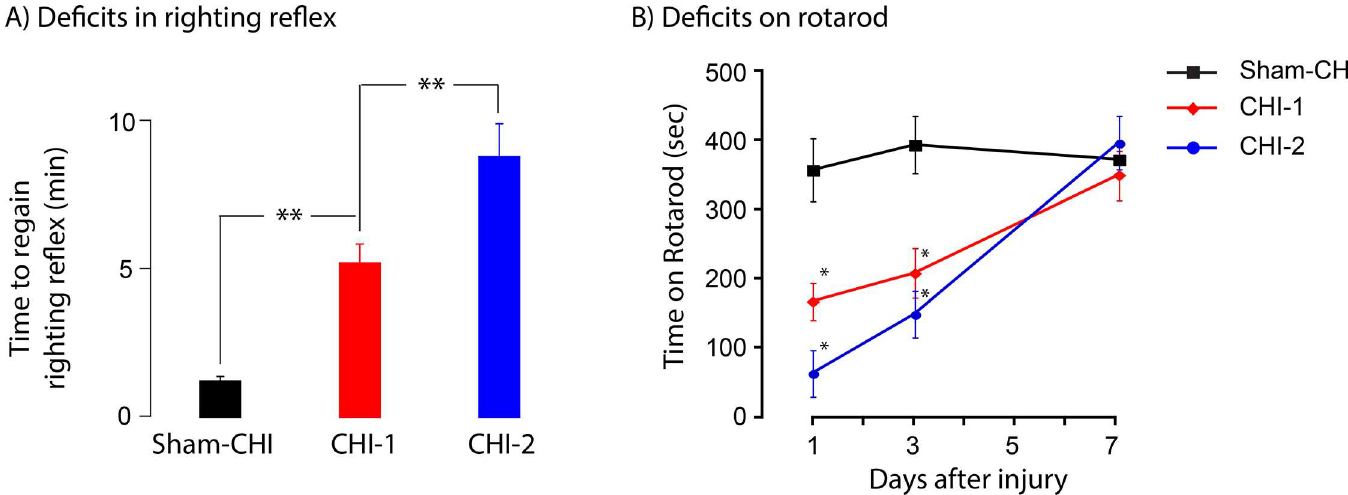
Fig 1. CHI-1 and CHI-2 mice have differing deficits in righting reflex and rotarod after closed head injury. Panel A, Assessment of righting reflex. Recovery of righting reflex differed among sham-CHI, CHI-1 and CHI-2 mice (ANOVA, F 2,30 = 18.4, p < 0.001). Sham-CHI mice recovered righting reflex most rapidly followedby CHI-1 and then by CHI-2 (post hoc p < 0.01). Panel B, One, three and seven days after either sham-CHI or CHI, mice received four 5-minute trials on the rotarod. Performance on the rotarod had a significant interaction between group and time (F 4,14 = 5.03, p = 0.01). Rotarod performance also had a significant effect between-subjects across days F 2,7 = 5.45, p = 0.04). The three groups significantly differed on the time on the rotarod on Days 1 (F 2,17 = 10.25, p = 0.001), and 3 (F 2,17 = 10.63, p = 0.001), but not on Day 7 (F 2,10 = 0.42, p = 0.68). The performance of the sham-CHI group on Day 1 and 3 was significantly better than the CHI-1 and CHI-2 groups (post hocs, p = 0.001). There were no statistically significant differences in rotarod performance between conditionson Day 7 suggestingthat the motor deficits at 1 and 3 days were